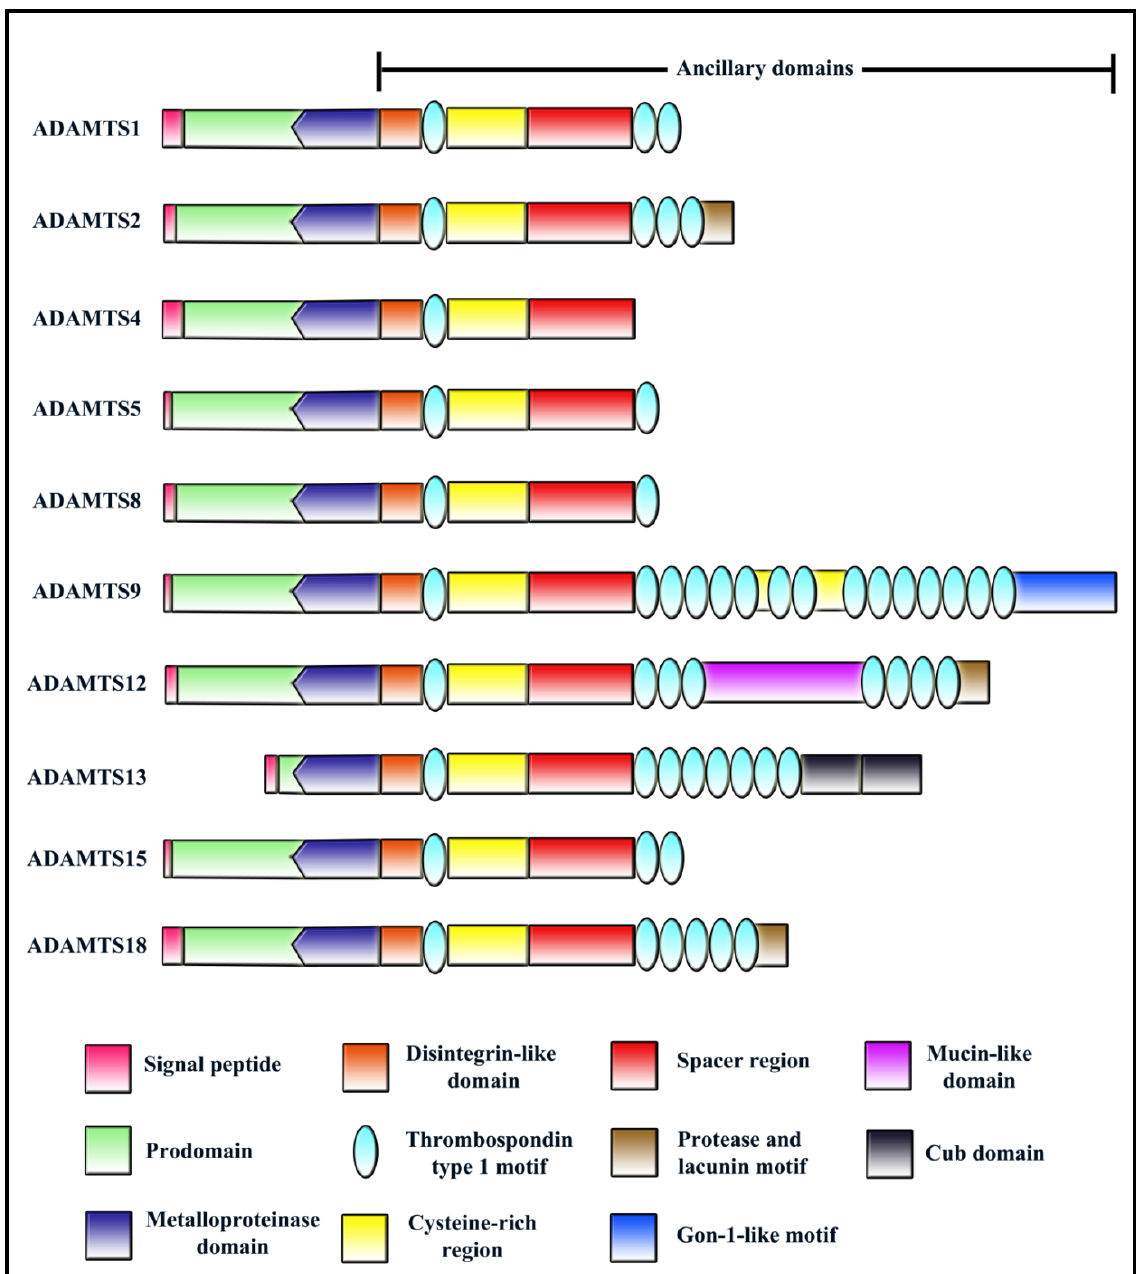
Figure 1. Domain structure of ADAMTS members with reported roles in